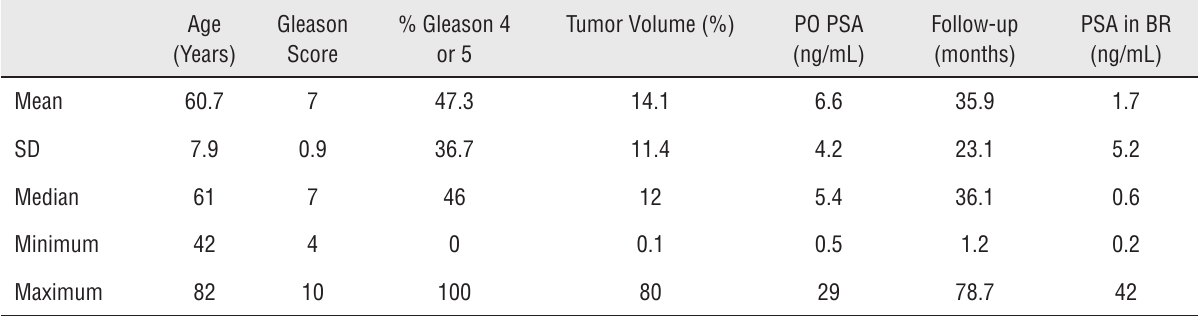
Table 1 - Demographic laboratory and histological characteristics of 365 patients submitted to radical prostatectomy to treat prostate